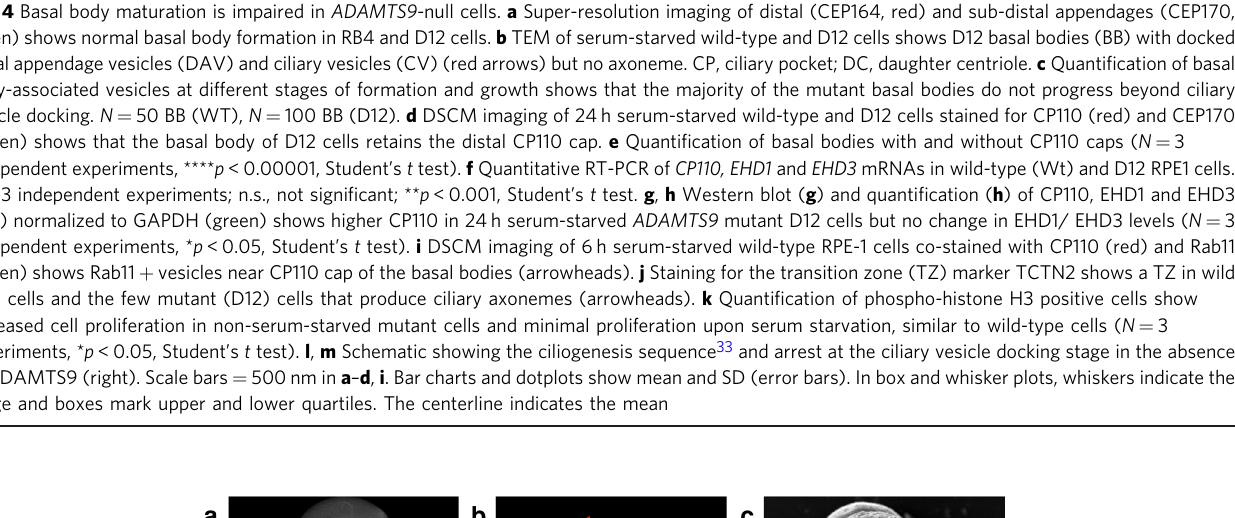
Fig. 4 Basal body maturation is impaired in ADAMTS9- null cells. a Super-resolution imaging of distal (CEP164, red) and sub-distal appendages (CEP170, green) shows normal basal body formation in RB4 and D12 cells. b TEM of serum-starved wild-type and D12 cells shows D12 basal bodies (BB) with docked distal appendage vesicles (DAV) and ciliary vesicles (CV) (red arrows) but no axoneme. CP, ciliary pocket; DC, daughter centriole. c Quanti fi cation of basal body-associated vesicles at different stages of formation and growth shows that the majority of the mutant basal bodies do not progress beyond ciliary vesicle docking. N = 50 BB (WT), N = 100 BB (D12). d DSCM imaging of 24 h serum-starved wild-type and D12 cells stained for CP110 (red) and CEP170 (green) shows that the basal body of D12 cells retains the distal CP110 cap. e Quanti fi cation of basal bodies with and without CP110 caps ( N = 3 independent experiments, **** p < 0.00001, Student ’ s t test). f Quantitative RT-PCR of CP110, EHD1 and EHD3 mRNAs in wild-type (Wt) and D12 RPE1 cells. N = 3 independent experiments; n.s., not signi fi cant; ** p < 0.001, Student ’ s t test. g , h Western blot ( g ) and quanti fi cation ( h ) of CP110, EHD1 and EHD3 (red) normalized to GAPDH (green) shows higher CP110 in 24 h serum-starved ADAMTS9 mutant D12 cells but no change in EHD1/ EHD3 levels ( N = 3 independent experiments, * p < 0.05, Student ’ s t test). i DSCM imaging of 6 h serum-starved wild-type RPE-1 cells co-stained with CP110 (red) and Rab11 (green) shows Rab11 + vesicles near CP110 cap of the basal bodies (arrowheads). j Staining for the transition zone (TZ) marker TCTN2 shows a TZ in wild type cells and the few mutant (D12) cells that produce ciliary axonemes (arrowheads). k Quanti fi cation of phospho-histone H3 positive cells show increased cell proliferation in non-serum-starved mutant cells and minimal proliferation upon serum starvation, similar to wild-type cells ( N = 3 experiments, * p < 0.05, Student ’ s t test). l , m Schematic showing the ciliogenesis sequence 33 and arrest at the ciliary vesicle docking stage in the absence of ADAMTS9 (right). Scale bars = 500 nm in a – d , i . Bar charts and dotplots show mean and SD (error bars). In box and whisker plots, whiskers indicate the range and boxes mark upper and lower quartiles. The centerline indicates the mean